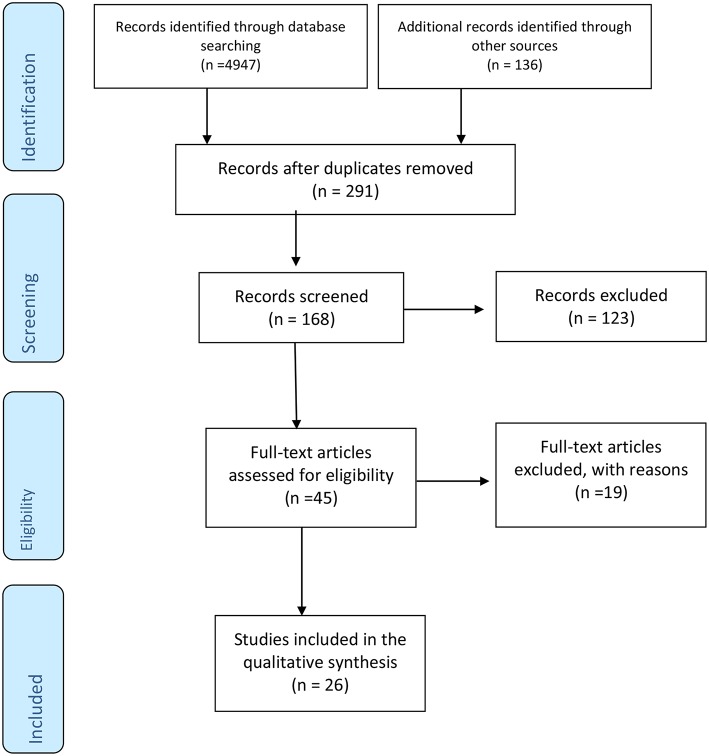
PRISMA diagram showing systematic search process, which started with 4,947 articles identified through searching Medline, EMBase, BIOSIS, Web of Science, CINAHL, and the entire Cochrane Library in addition to 136 articles retrieved from the references list of the selected studies. Duplicate articles were excluded. From 168 articles screened, 123 articles were excluded because they didn't meet the inclusion criteria (animal studies, letter to the editor, case reports). The number of full articles assessed for eligibility was 45, of which 19 articles were found not- eligible due to lacking a PE group, lacking a healthy control group or including non pregnant women with history of PE. Finally, 26 studies were found eligible for inclusion in our review.